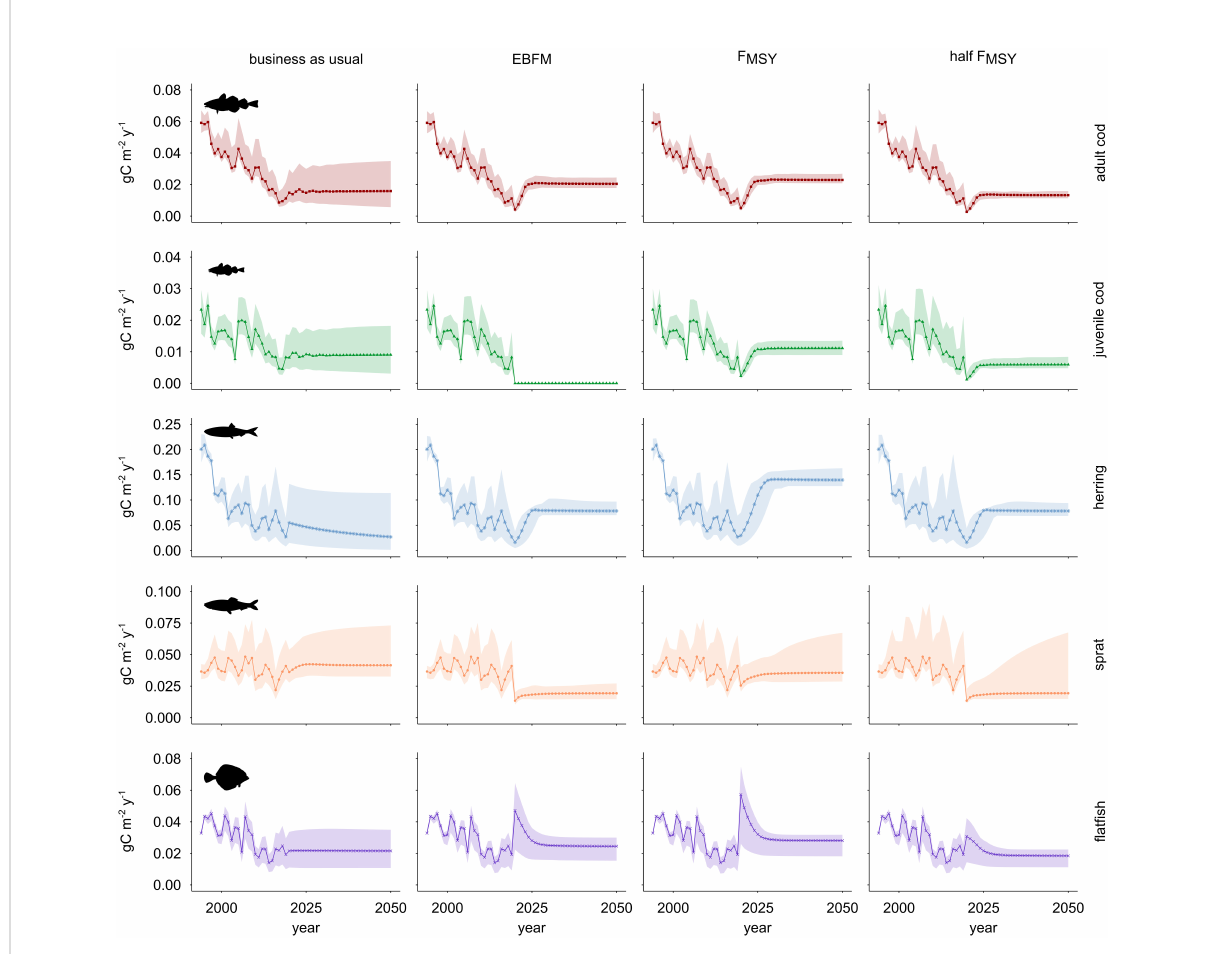
FIGURE 5 Catch of commercially most relevant fi sh stocks in the WBS ecosystem under four alternative fi sheries management scenarios. Columns refer to fi shing regimes: business as usual (BAU), Ecosystem-Based Fisheries Management (EBFM), maximum sustainable yield (F maximum sustainable yield (F MSY ). Rows show trends for the various trophic groups. Solid lines depict the predictions generated using the reference model while shaded areas indicate approximate 95% con fi dence